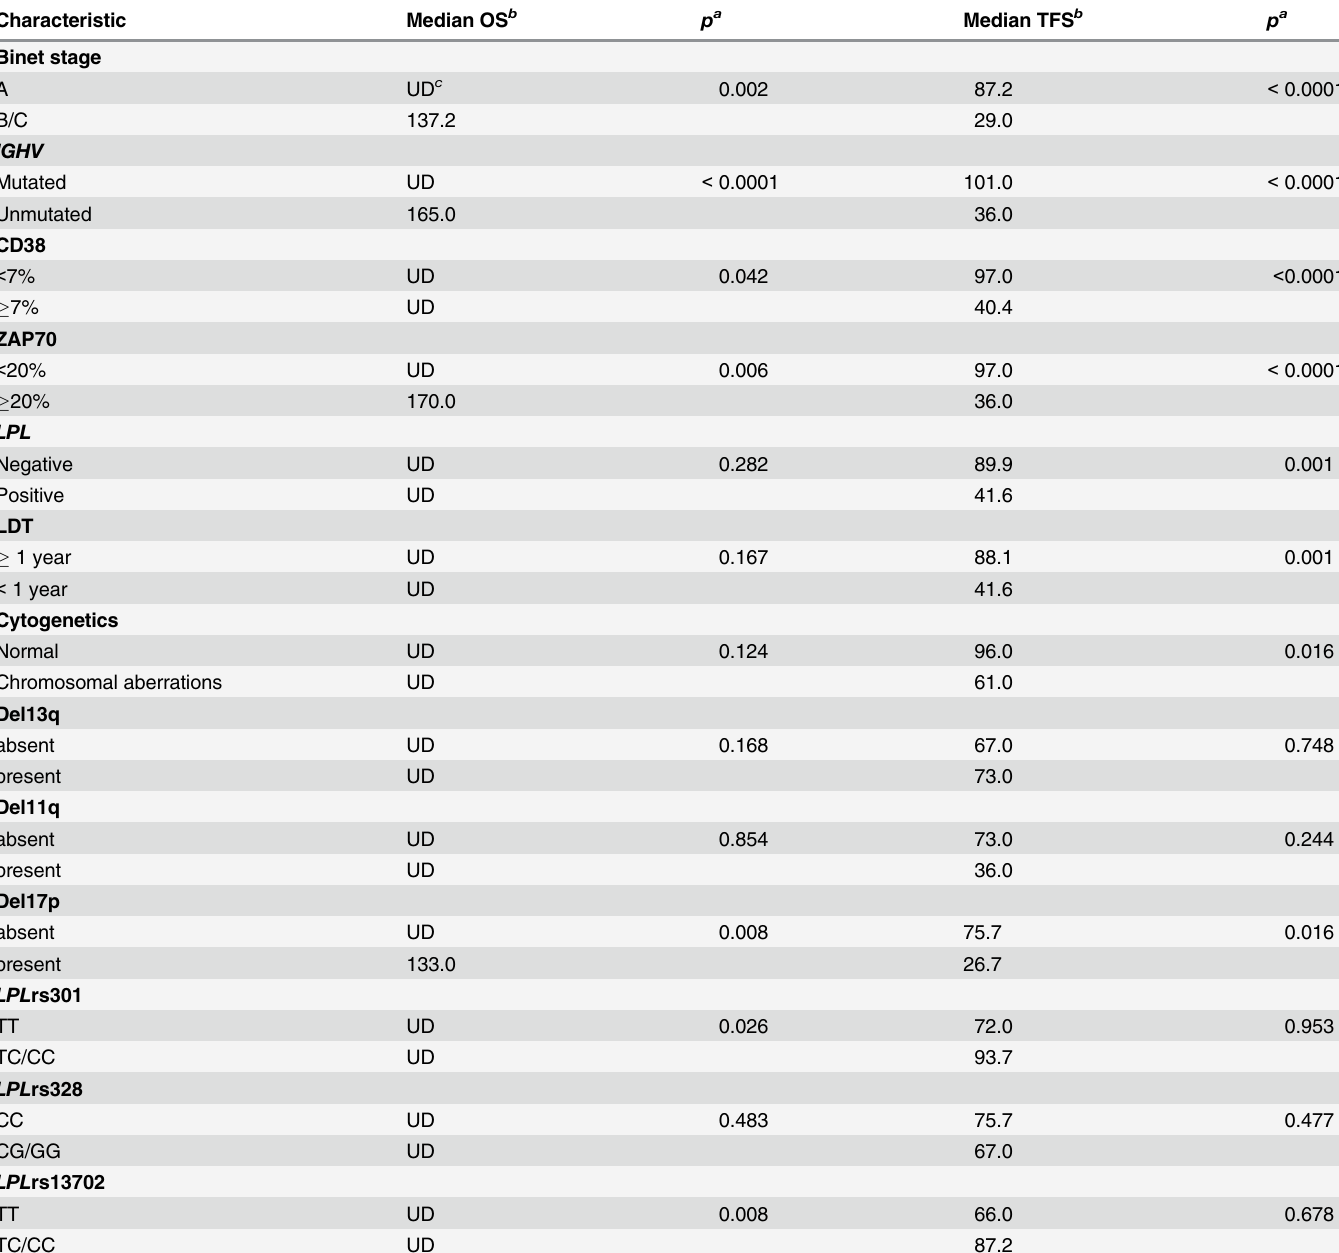
Table 3. Survival data for different biological and clinical characteristics and LPL